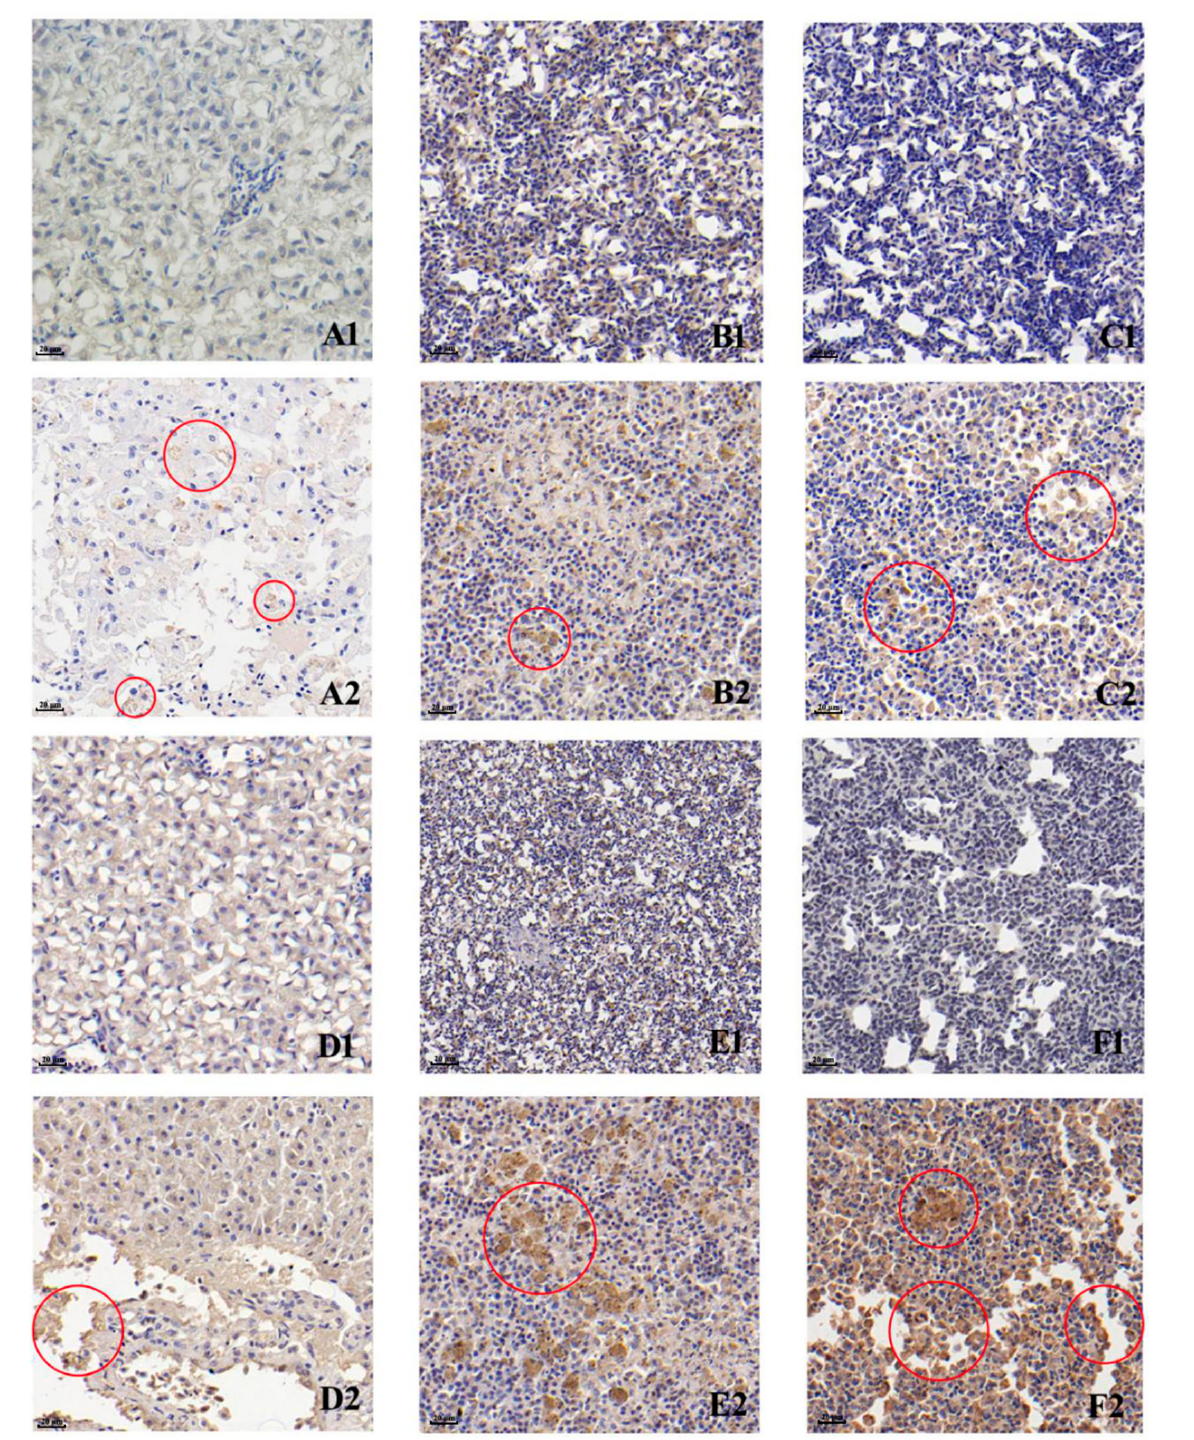
Figure 3. Immunohistochemistry detection of LMBV and HSHRV-like virus in naturally virus-infected largemouth bass suing specific polyclonal antisera. Anti-MSRV staining of livers of ( A1 ) healthy and ( A2 ) diseased fish; spleens of ( B1 ) healthy and ( B2 ) diseased fish; and kidneys of ( C1 ) healthy and ( C2 ) diseased fish. Anti-LMBV staining of ( D1 ) healthy and ( D2 ) diseased fish; spleens of ( E1 ) healthy and ( E2 ) diseased fish; and kidneys of ( F1 ) healthy and ( F2 ) diseased fish. Scale bars, 20 µm.